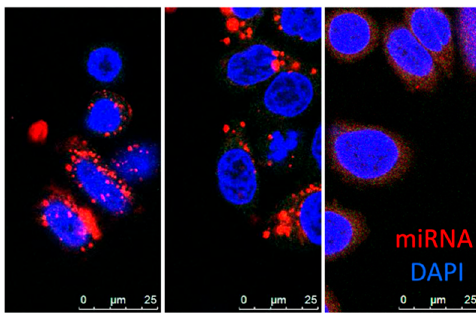
Figure 2. MiRNA uptake via nanoparticles. The confocal images of Dy547 labeled miRNA mimic (red) delivery to SKBR3 cells by PEI (left), lipofectamine2000 (middle), or EV (right) with DAPI staining (blue) at 24-hr time point. (Images provided by the Harada Lab).